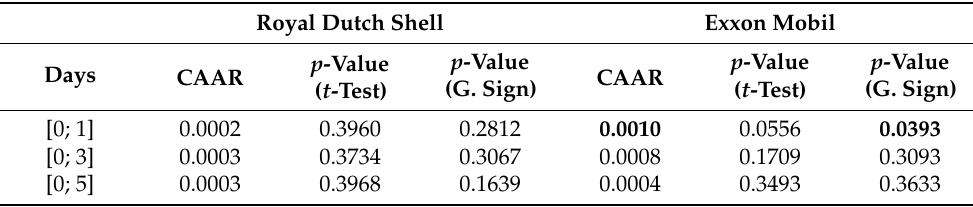
Table 2. Cumulative average abnormal returns Royal Dutch Shell and Exxon Mobil—Slochteren and Anadarko induced seismicity combined ( df = 726).